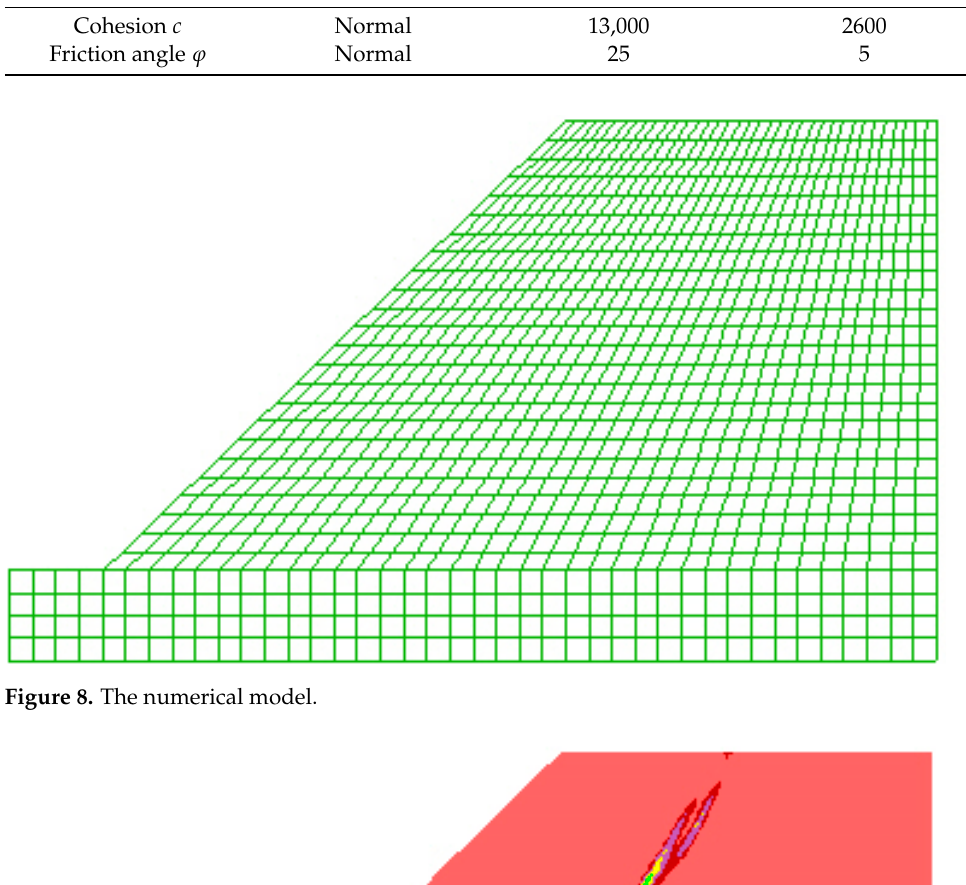
12 of 17 Figure 7. Probability distribution of safety factor and its comparison with MCS for frictional soil with pore pressure. 5.2. Example 2: Soil Slope This example compares the proposed method to the traditional polynomial response